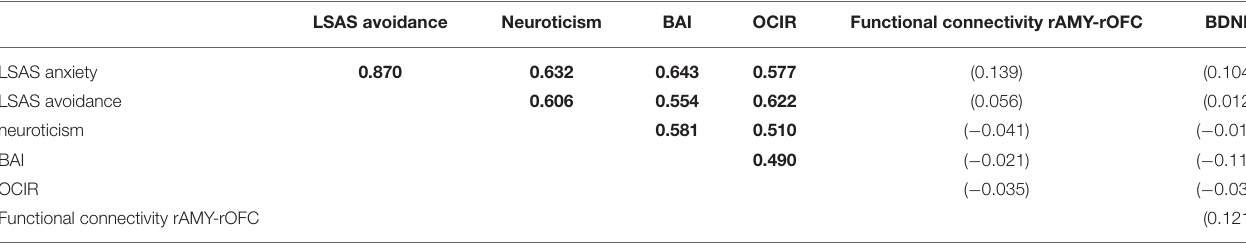
TABLE 3 | Correlations between psychiatric indicators and physiological variables. LSAS avoidance Neuroticism BAI